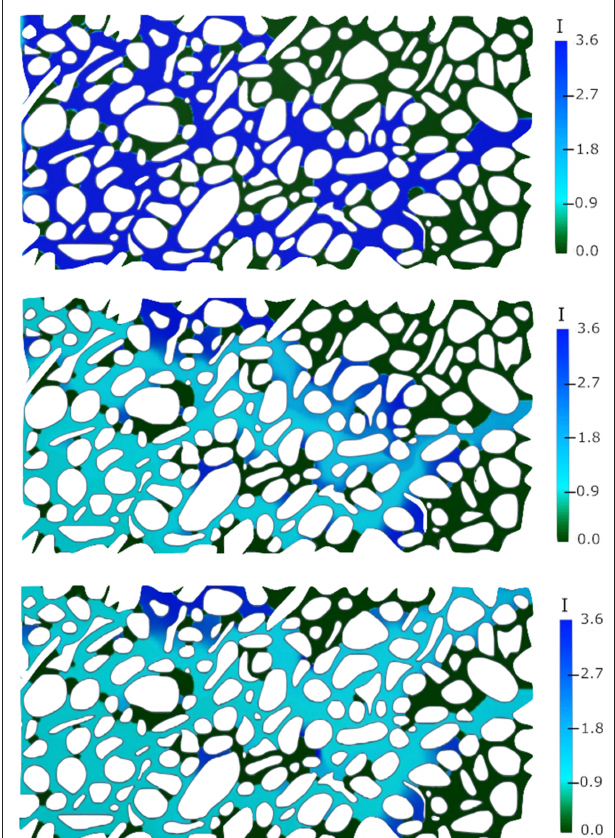
FIGURE 11 | Numerical simulation of tertiary low-salinity flooding in a micromodel. The colormap corresponds to the ionic strength (mol/l) in the domain. The non-aqueous phase appears in green ( I = 0), the high salinity water appears in dark blue ( I = 3.6) and the low-salinity water appears in light blue ( I = 0.9). The simulation parameters are fully described in Maes and Geiger (2018).